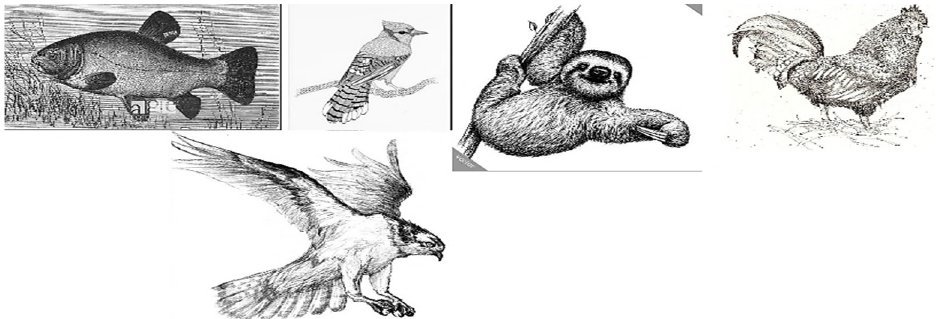
Figure 2. ImageNet instances